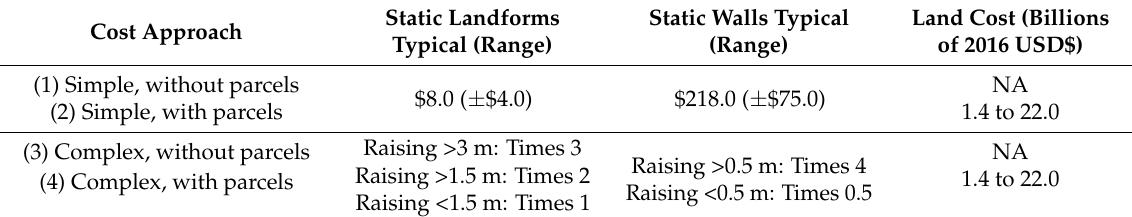
Table 4. Cost estimates by infrastructure type and analysis